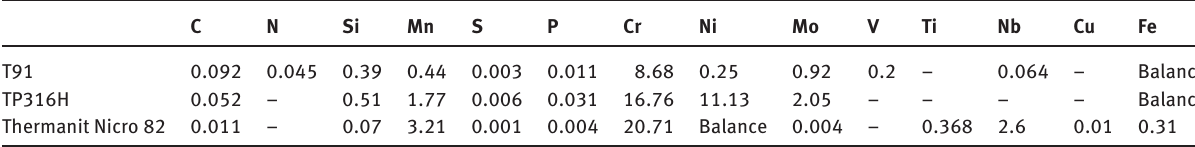
Table 1: Chemical composition [mass%] of the materials used for fabrication of T91/TP316H welded joint with Ni-based filler metal Thermanit Nicro 82.